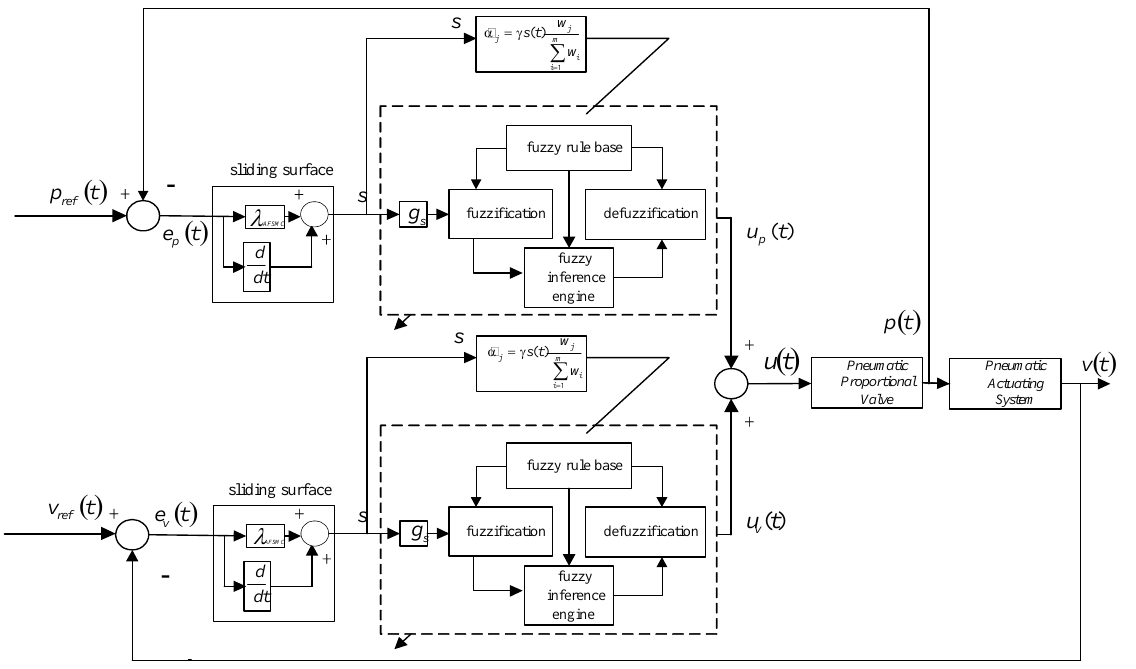
Figure 3. The overall control block diagram of the AFSMC control